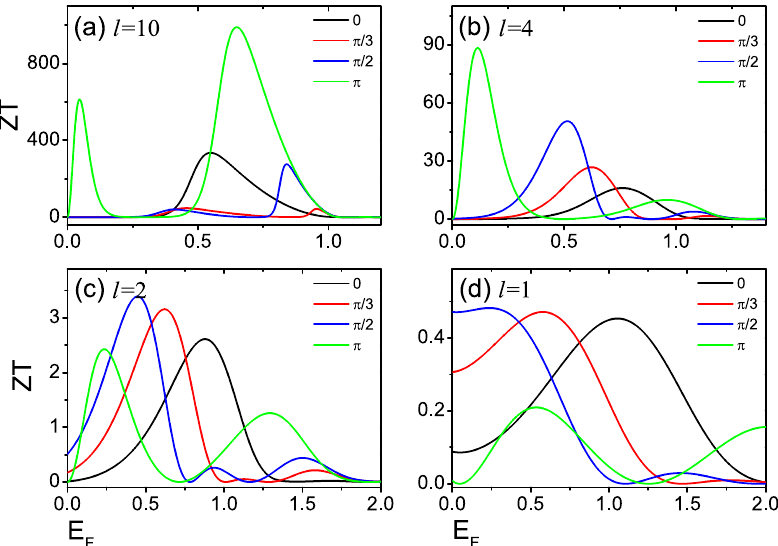
Figure 4. The thermoelectric figure of merit ZT as functions of Fermi energy E F for several relative tilt φ with temperature T / T 0 = 0.02 in ( a ), and T / T 0 = 0.05 in ( b ), and T / T 0 = 0.1 in ( c ) and T / T 0 = 0.05 in ( d ). The other unmentioned parameters are the same as in Fig. 3.